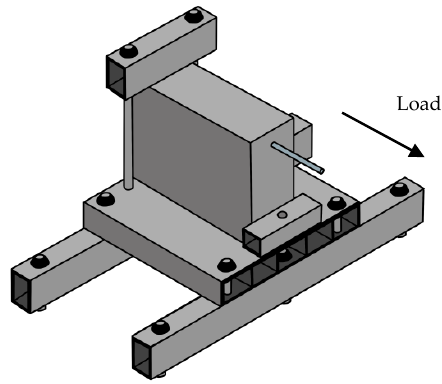
Figure 2. Sketch of the beam end pull out test.